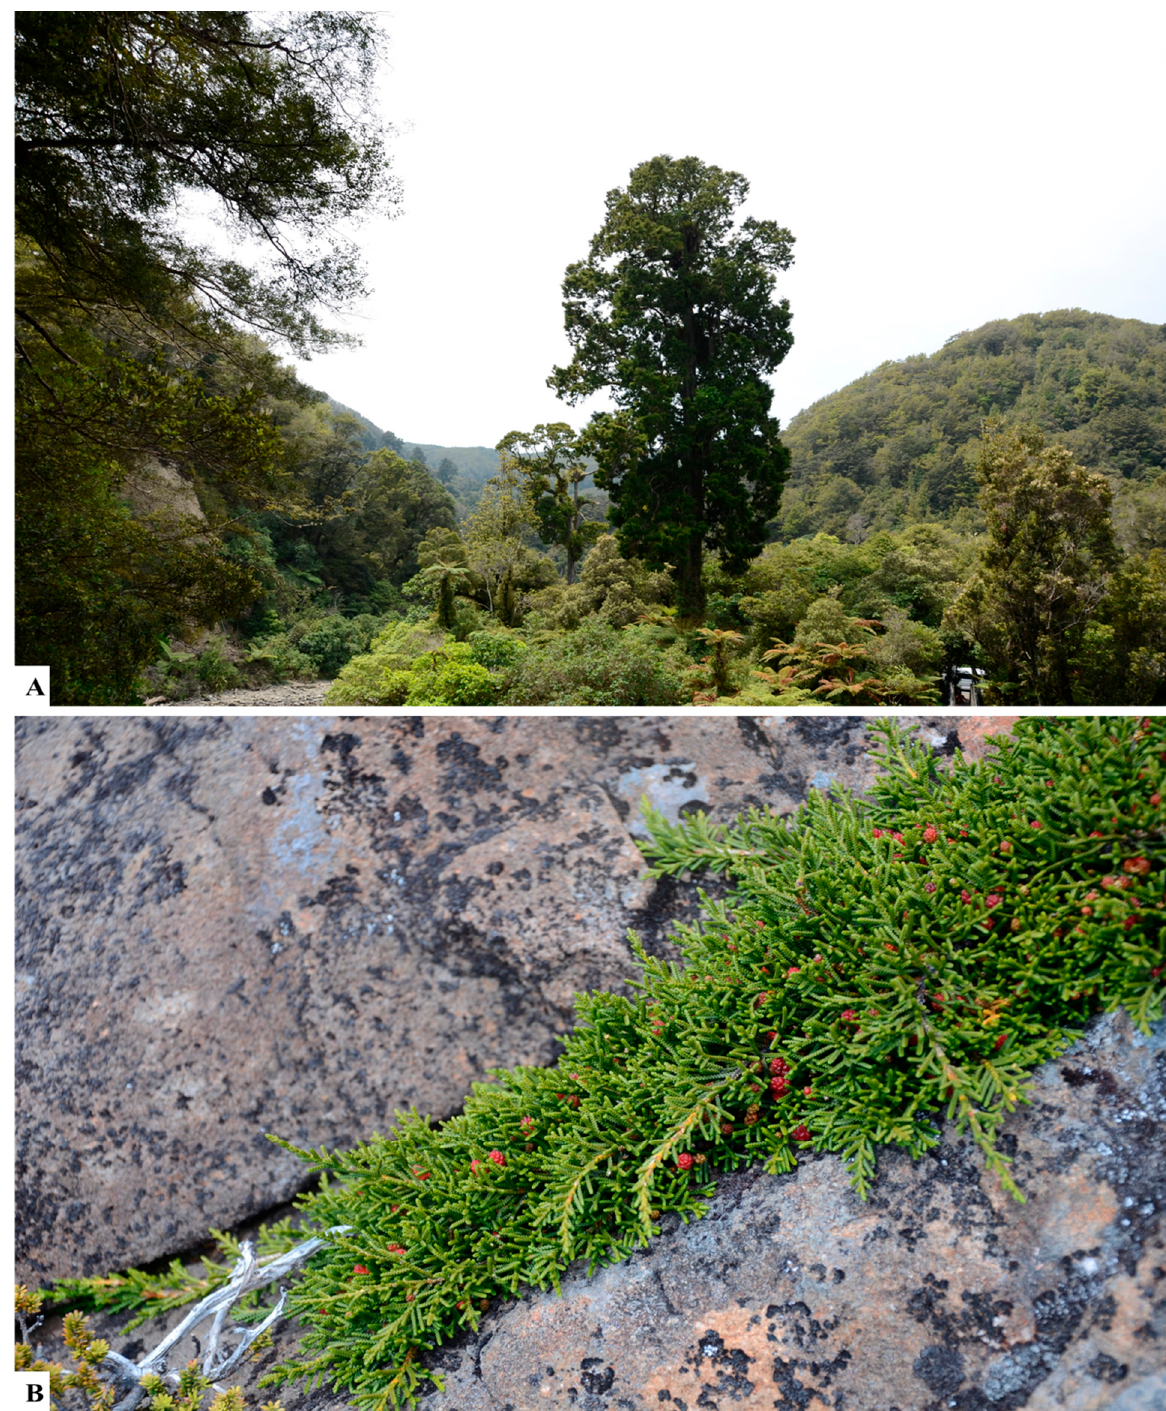
Figure 3. ( A ) Dacrycarpus dacrydioides (White pine, Kahikatea) tree in the rainforest of Wellington Kaitoke Regional Park, New Zealand. ( B ) Microcachrys tetragona (Strawberry pine) is a creeping shrub in the alpine region of cradle mountain summit, Tasmania.